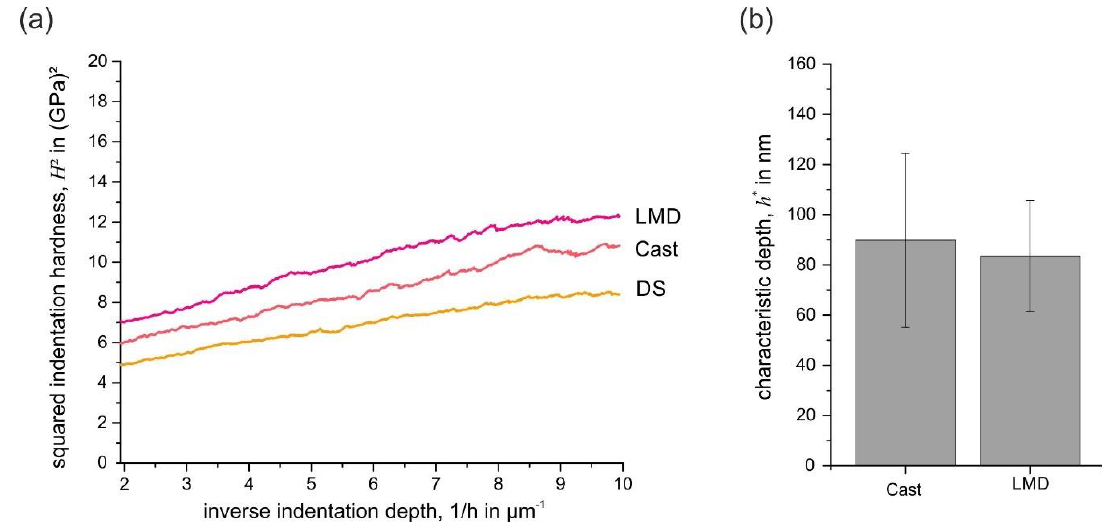
Figure 21. ( a ) Nix-Gao plot of nearly (001)-oriented grains and ( b ) calculated characteristic depth h* calculated from at least three indentation experiments (CSM method).